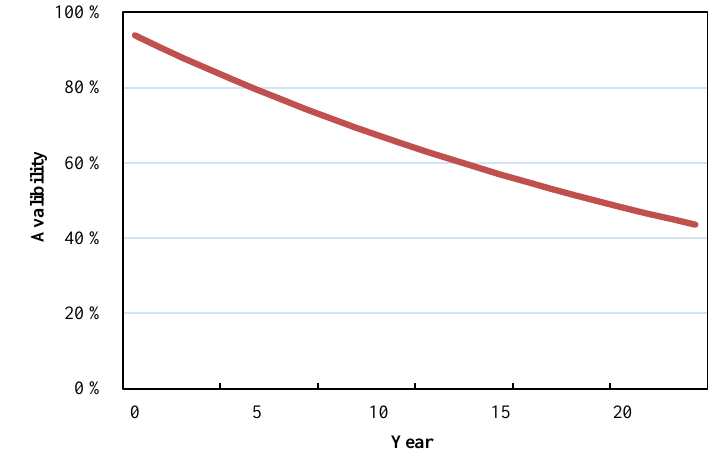
Fig. 3. The effect of operation year on availability of PV